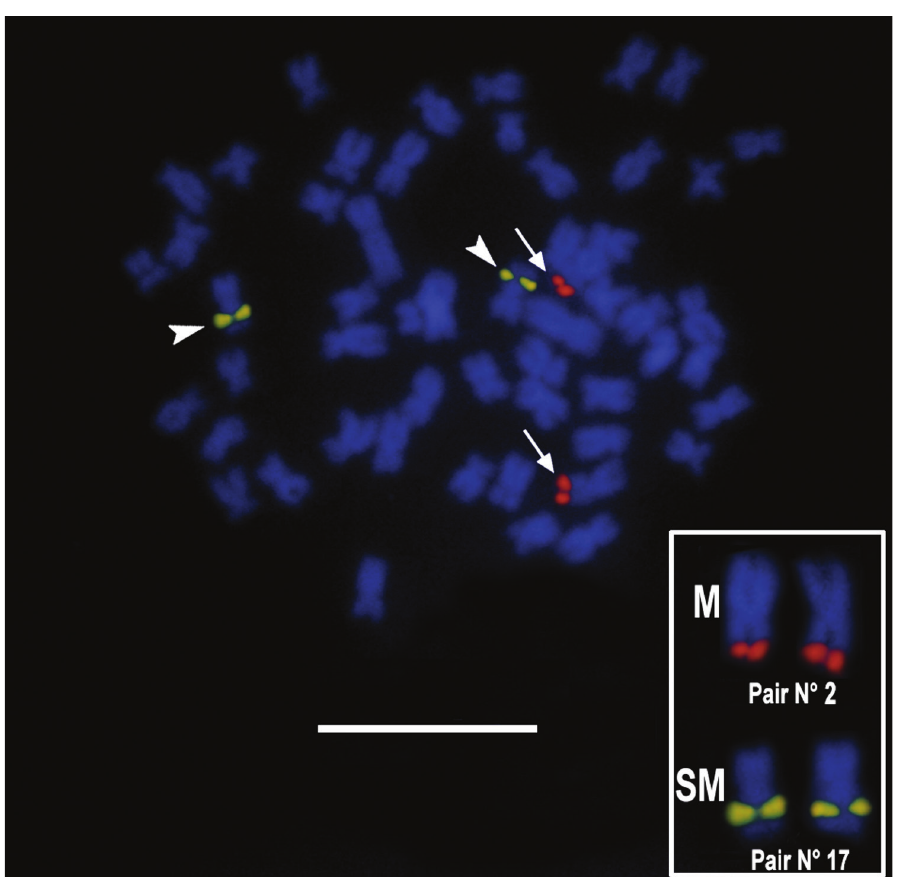
Figure 3. Double FISH staining of metaphase chromosomes of Ichthyoelephas humeralis (arrows show the 18S rDNA, and arrowheads show the 5S rDNA); inbox details of chromosome bearing 5S and 18S rDNA. Bar = 10